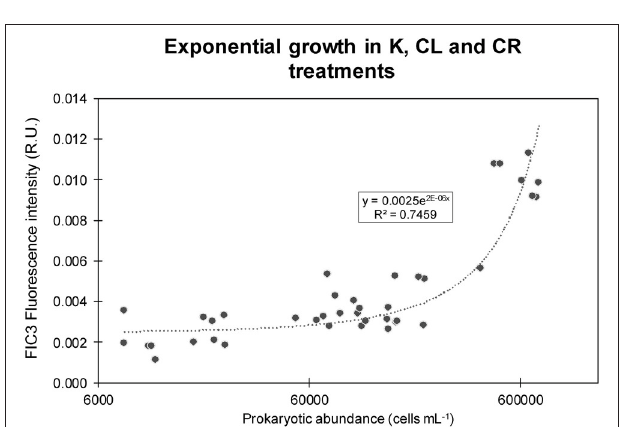
FIGURE 7 | Exponential growth model of FIC3 intensity vs. bacterial abundances for all the K, CL, and CR treatments together. Prokaryotic abundances are expressed in cells mL − 1 and fluorescence intensities in R.U.